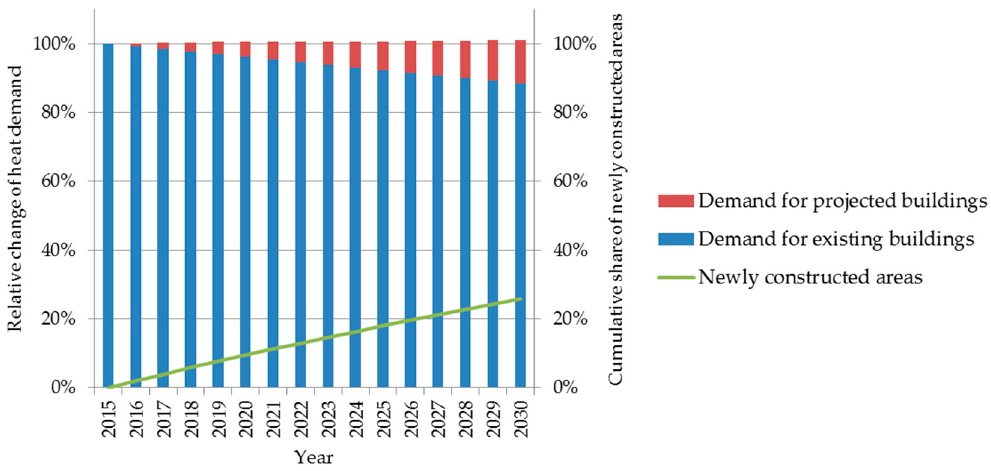
Figure 8. Heat demand projection in 15 years of the existing and expected buildings as well as the growth of newly constructed areas.